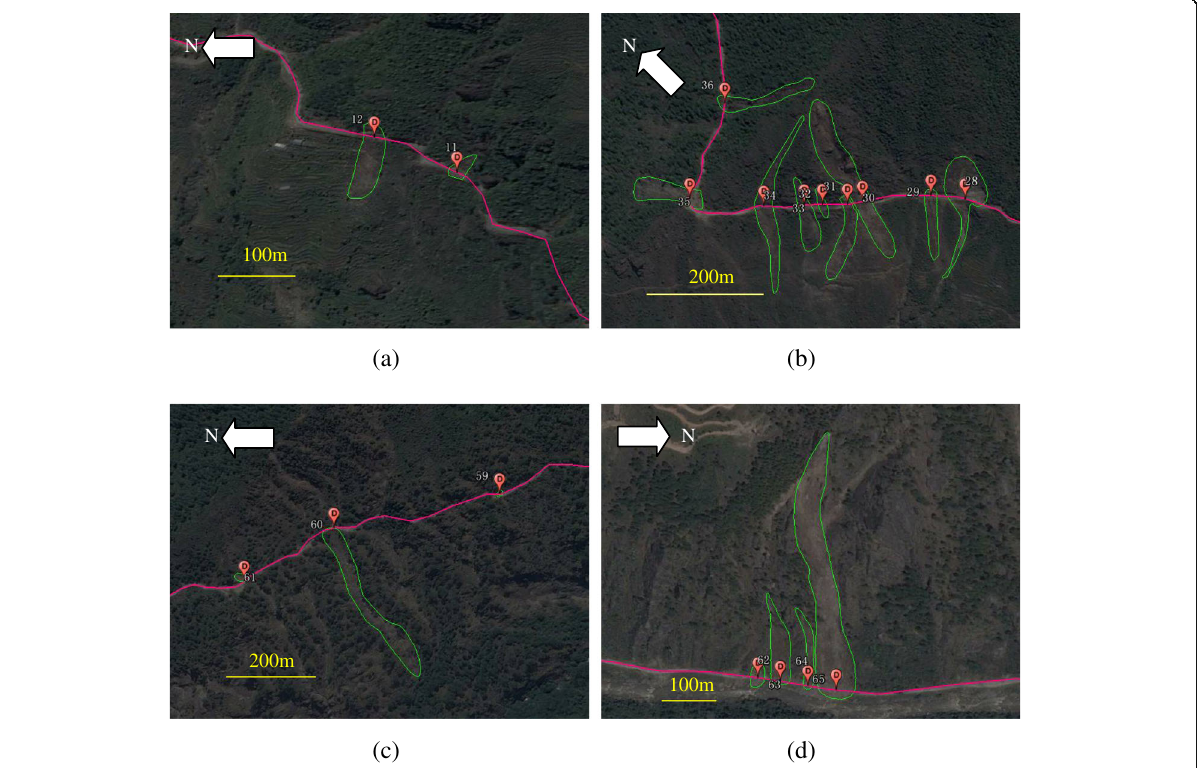
Fig. 8 Damaged sites along Pasang Lhamu Highway by coseismic landslides on satellite images. The detailed information of the landslides and associated damages on the road is listed in Table 2. a the No. 11 and 12 landslides, ( b ) the No. 28~36 landslides, ( c ) the No. 59, 60, and 61 landslides, ( d ) the No. 62, 63, 64, and 65 landslides along Pasang Lhamu Highway. All the satellite images were acquired on 3 May,